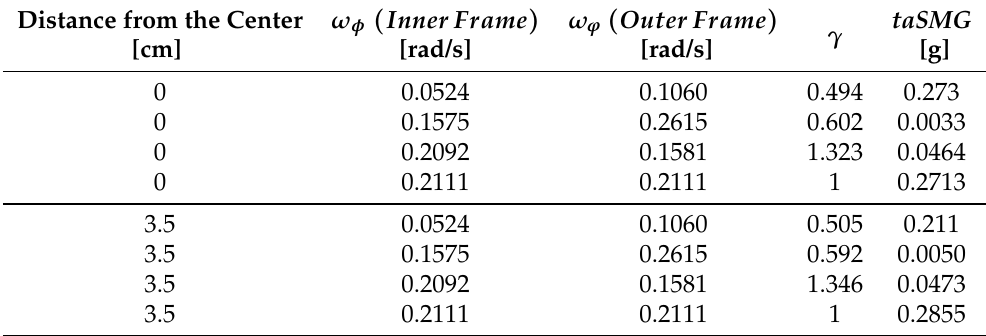
Figure 1. Images of the RPM: ( a ) The assembled machine; ( b ) The design of the chambers for the animals. The control unit regulates the rotational parameters (angular velocities, direction of rotation and periods of rotation) of the frames. Variations of fixed rotational parameters (Table 1) based on literature references are chosen to ensure objective testing of the prototype in 3D mode. For the random mode, all parameters were randomly selected from a range of values by a software algorithm. Table 1. Rotational parameters in 3D